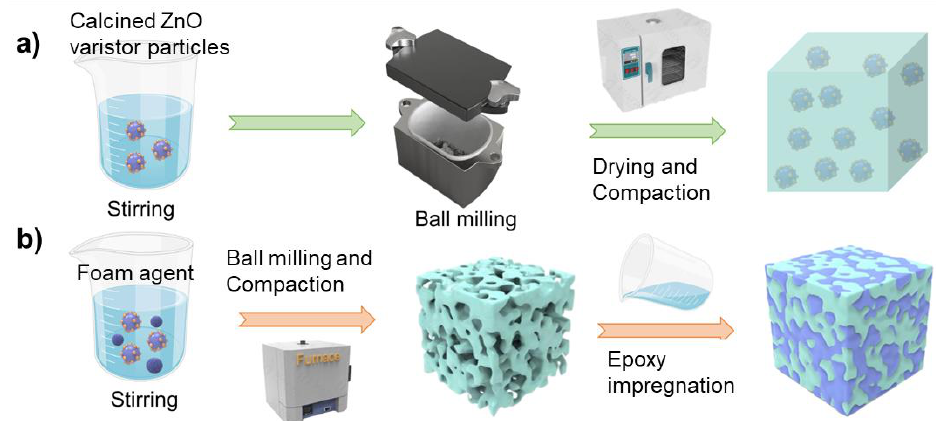
Figure 2. ( a ) Conventional mixing fabrication of composites; ( b ) Impregnated form ceramic fabrica-